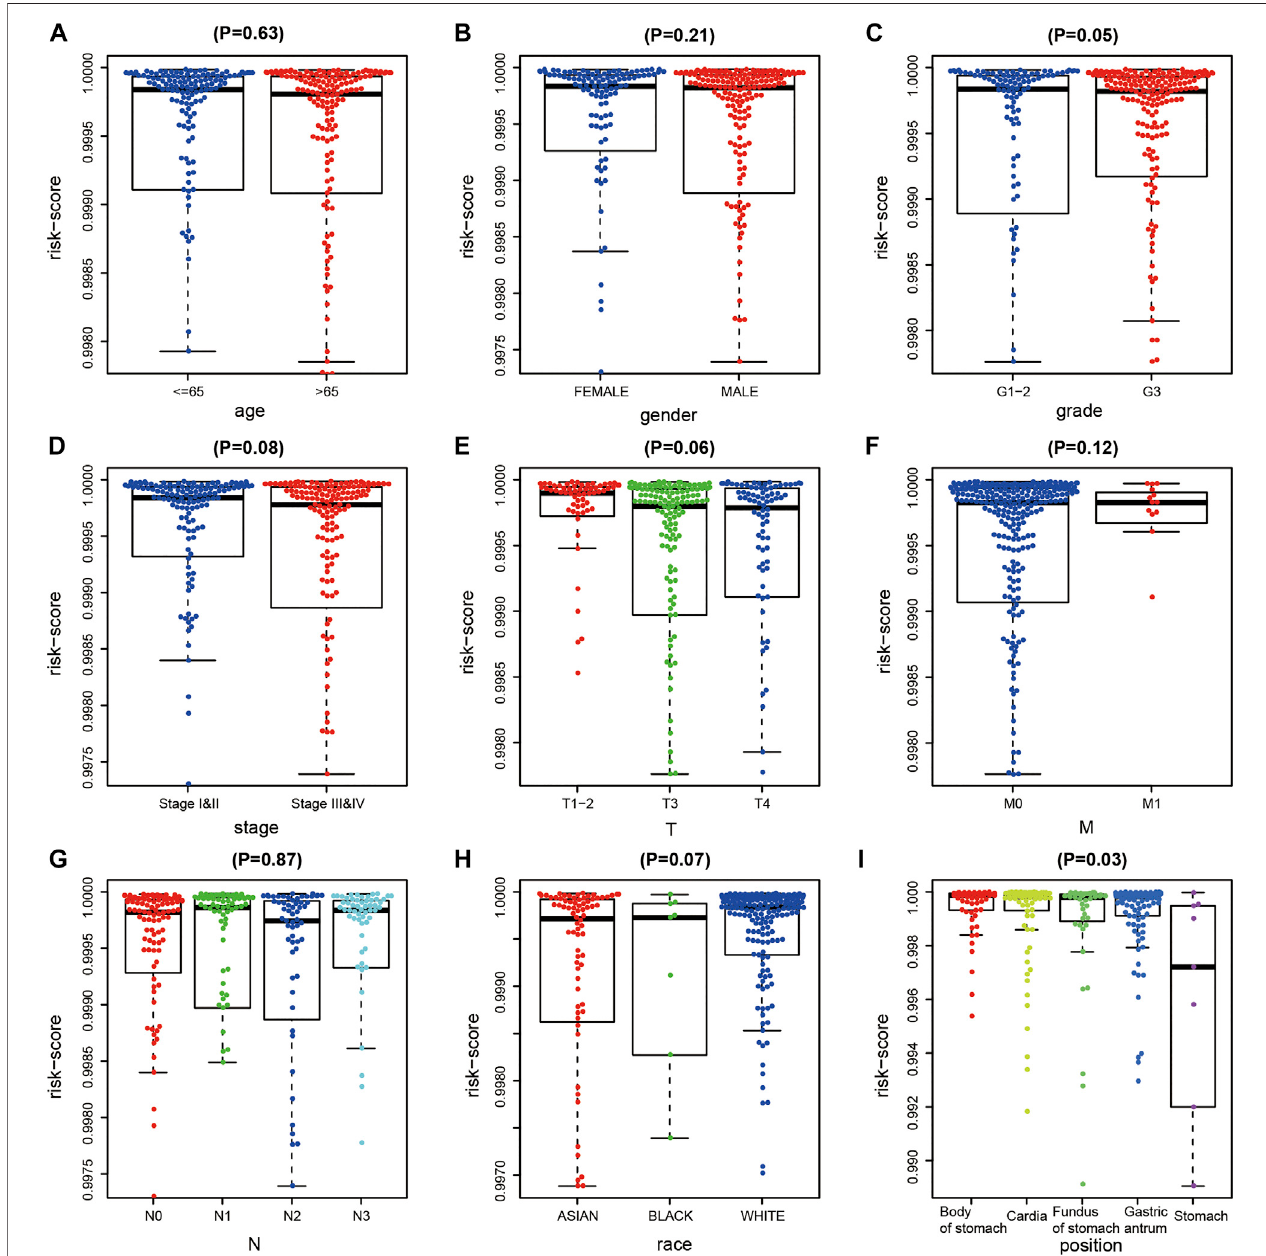
FIGURE 4 | Correlation analysis of DNA methylation (DNAm) diagnostic model and clinical indicators in gastric cancer (GC). (A – I) Correlation analysis between diagnostic risk score and age, gener, tumor grade, T, M, N stage, race, and tumor site of gastric cancer.